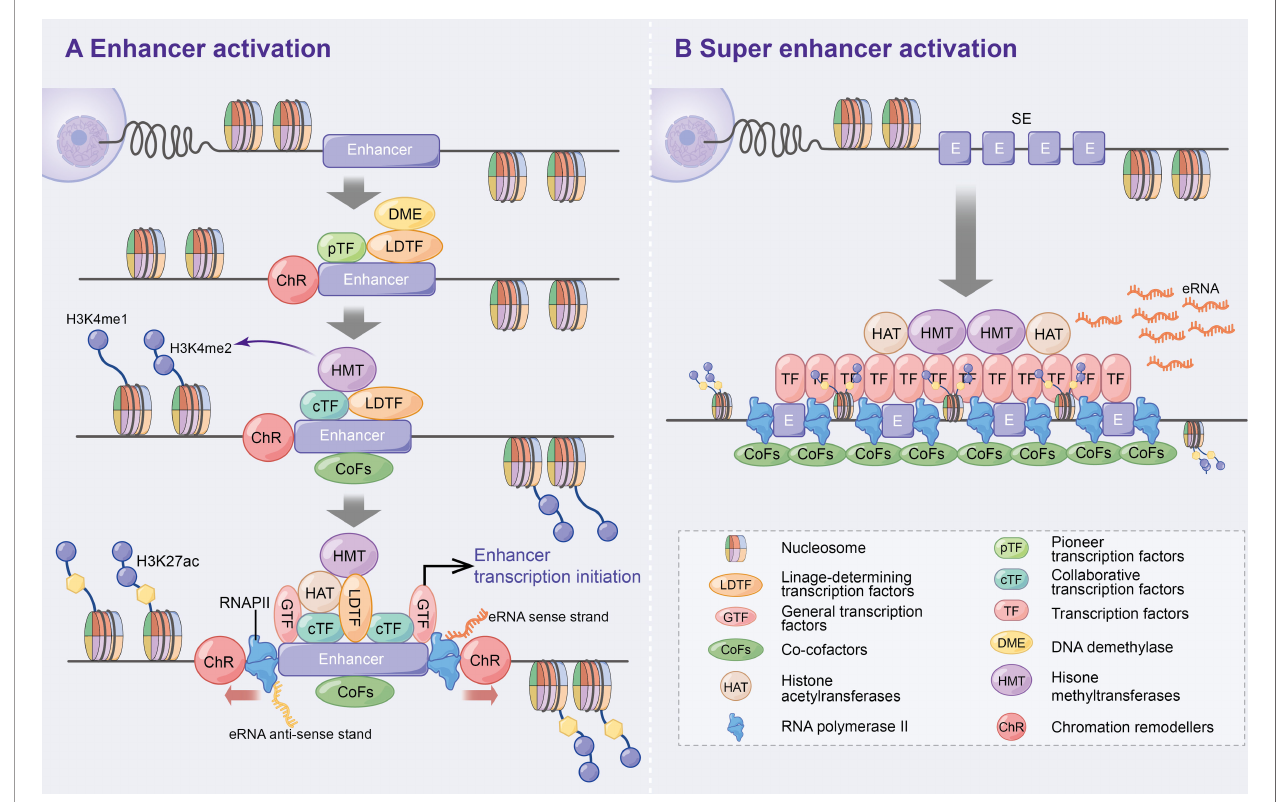
FIGURE 1 | Activation mechanism of enhancers and super enhancer. (A) Enhancer activation. Multifactorial stimulation causes pTFs binding to nucleosomes leading to ChR and further recruitment of LDTFs, cTFs and CoFs that assist enhancer activation and histone methylation. On this basis, HAT, GTFs and RNAPII are recruited and ultimately contribute to enhancer transcription bi-directionally. In addition, DME are recruited to regulate DNA methylation and p300 status at the initial stage of enhancer activation. (B) Super enhancers are large clusters of enhancers with high levels of cell-speci fi c transcription factors and cofactors that can ultimately express higher levels of